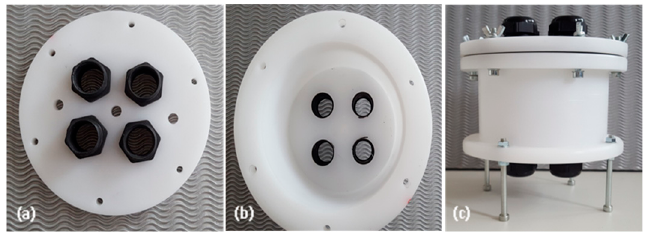
Figure 1. Photos of ( a ) the top lid, ( b ) the internal view and ( c ) the MFC units. Graphite granules (type 00514, Le Carbone, Belgium), with diameters ranging